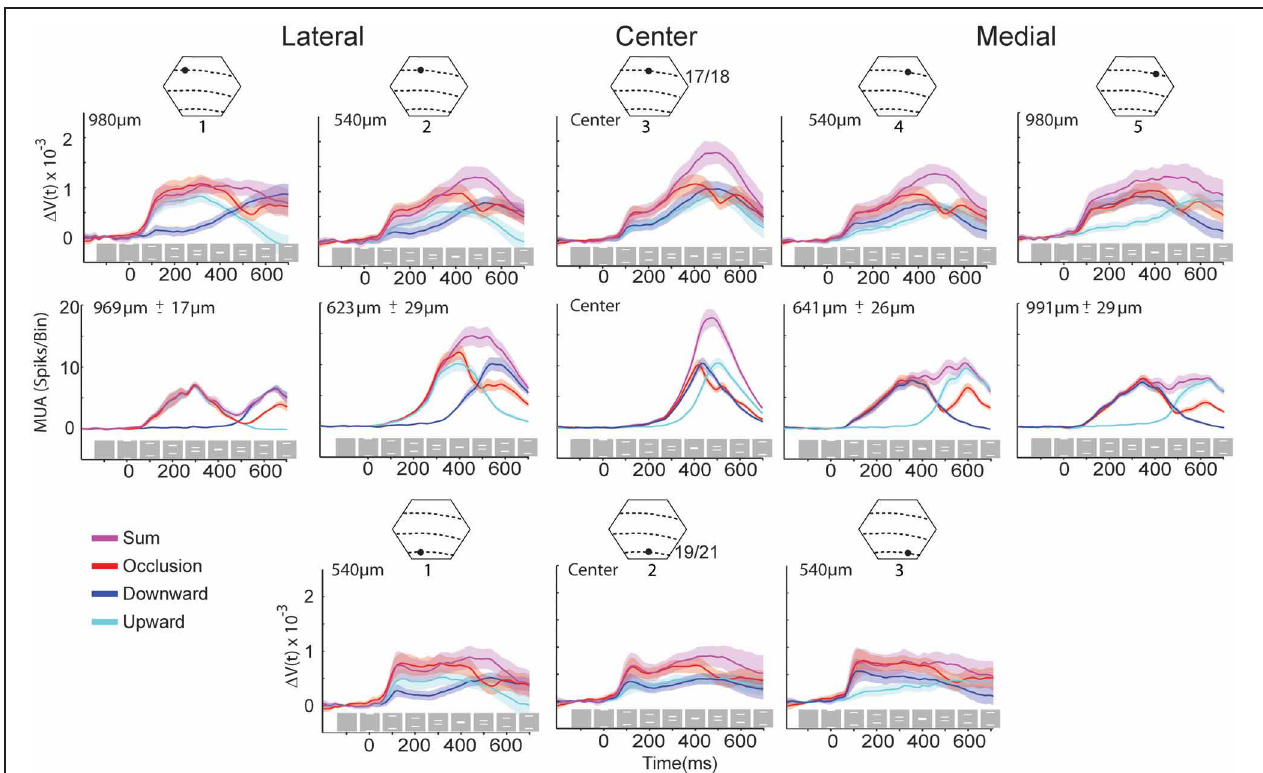
appears at the top left of each graph. The gray boxes with white bars indicate the position of the stimulus on the monitor for the different time points for the occlusion condition only. Solid lines indicate the mean and shaded regions indicate the standard error of mean, for each trace. For the (cid:3) V ( t ) N = 14 animals at each site and the MUA represents the average activity across all 16 leads of the laminar probe for N = 10 animals at each